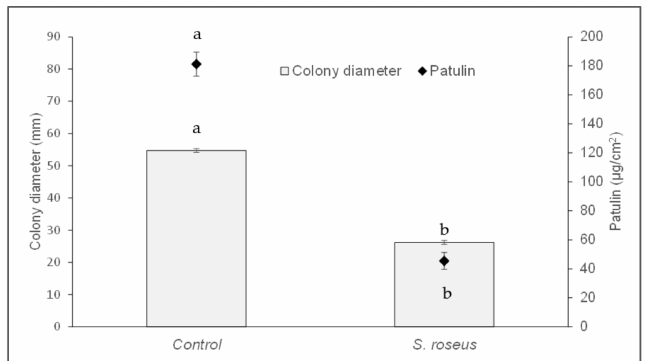
Figure 2. Effect of Sporobolomyces roseus on Penicillium expansum colony diameter (mm) and patulin production ( µ g/cm 2 ). Data are the mean of three replicates ± standard error of the mean (SEM). For each parameter, bars with different letters are statistically significant ( p ≤ 0.05) according to Duncan’s Multiple Range Test (DMRT).